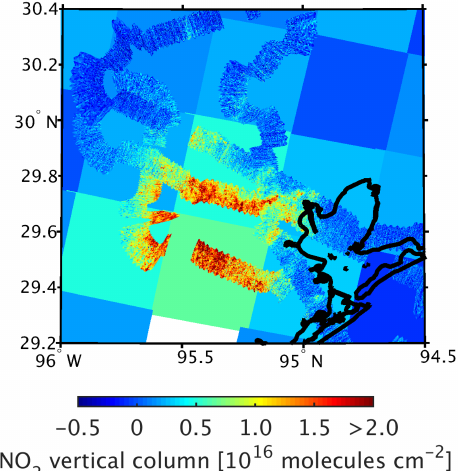
Figure 18. GeoTASO NO 2 tropospheric vertical columns at 250m × 250m resolution from 10:20 to 11:30LT, retrieved for cloud-free observations on 13 September plotted over GOME- 2/Metop-A tropospheric vertical columns where radiative cloud fraction is less than